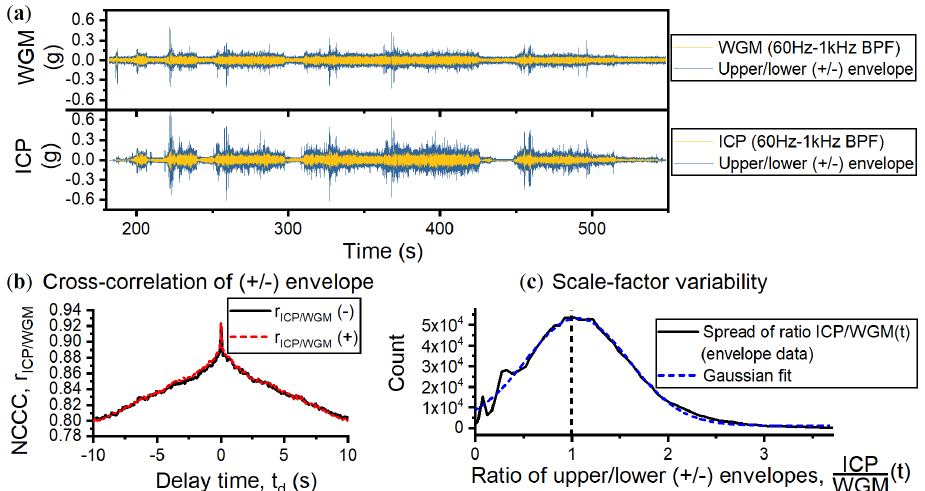
Figure 8. ( a ) Filtered trial data with the peak acceleration defined by upper (+) and lower ( − ) envelopes in blue. ( b ) Cross-correlogram of enveloped data where both envelopes have r ICP/WGM = 0.92. ( t ) of the enveloped data only (black solid line), fitted with ( c ) The distribution of the ratio ICP WGM ( t ) = 1.06 ± a Gaussian distribution (dashed blue line); the mean is ICP WGM